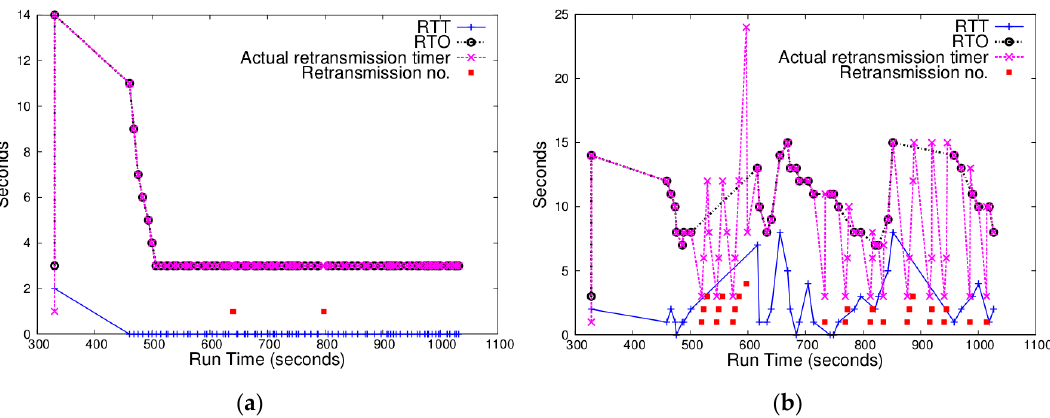
Figure 2. Changes of RTT (blue), RTO (black), actual retransmission timer (pink), and retransmission counter (red) for a node in a 5 × 5 grid topology: ( a ) with NullRDC enabled (i.e., no RDC enabled); ( b ) with ContikiMAC enabled.